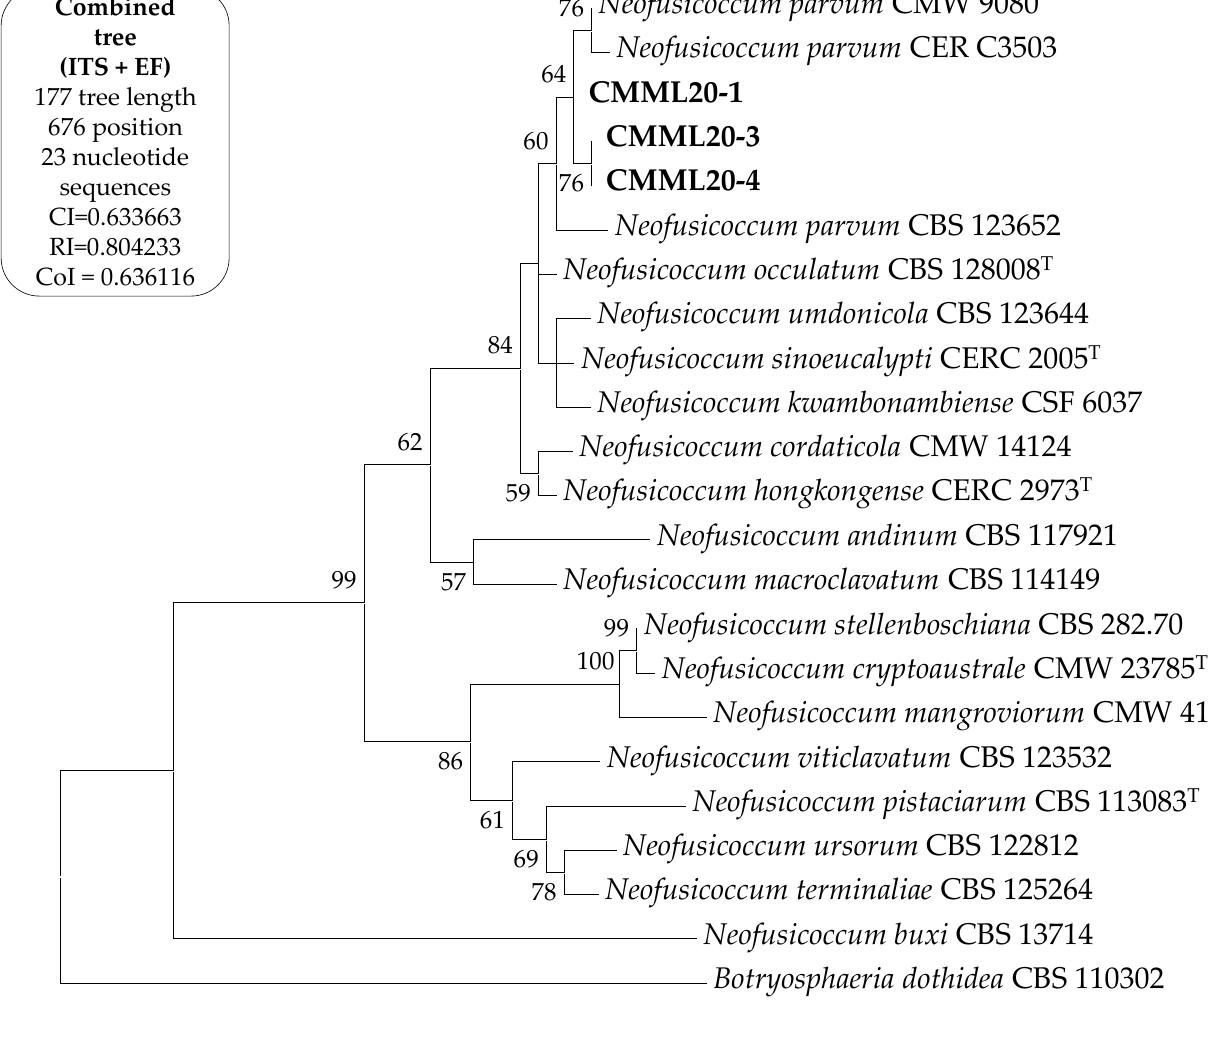
Figure 2. A maximum parsimonious tree of the combined datasets of the internal transcribed spacer (ITS) and elongation factor 1- α (EF1- α ) sequences of the present study isolates and their relatives from GenBank. The consistency index is 0.633663; the retention index is 0.804233; and the composite index is 0.636116 (0.509613) for all sites and parsimony-informative sites. The percentage of replicate trees in which the associated taxa clustered together in the bootstrap test (1000 replicates) are shown next to the branches. Bootstrap values >50% are indicated above the branches. This analysis involved 23 nucleotide sequences. All positions containing gaps and missing data were eliminated. There was a total of 676 positions in the final dataset. Evolutionary analyses were conducted in MEGA X. The present study isolates are marked in bold; ‘T’ indicates type strain.